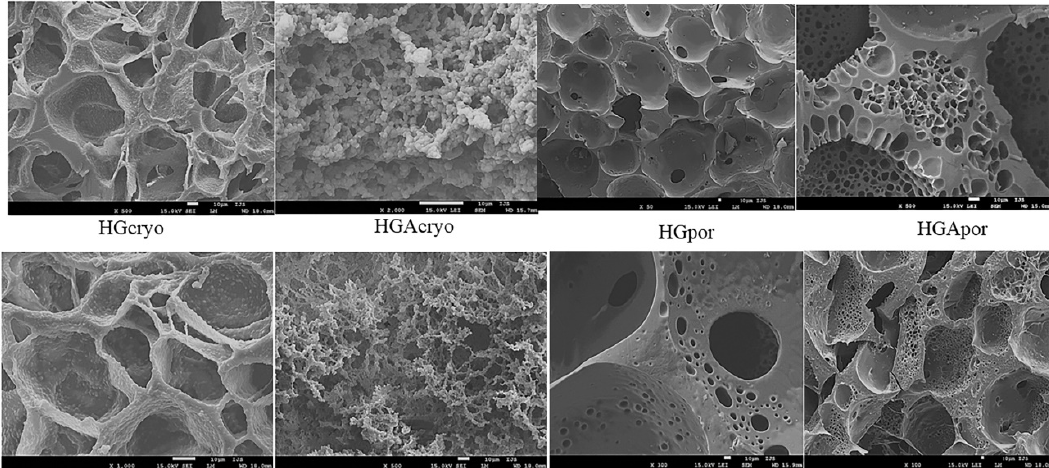
Figure 2. Representative SEM micrographs of the surface and a cross-section for HG cryo , HGA cryo , HGA por , HGA por samples (scale bar: 10 μ m).